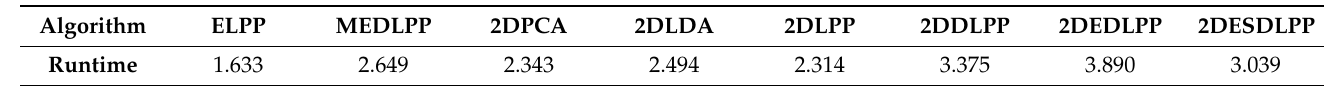
Table 3. The runtime (s) of eight different algorithms when the number of training samples in the ORL database is 6.